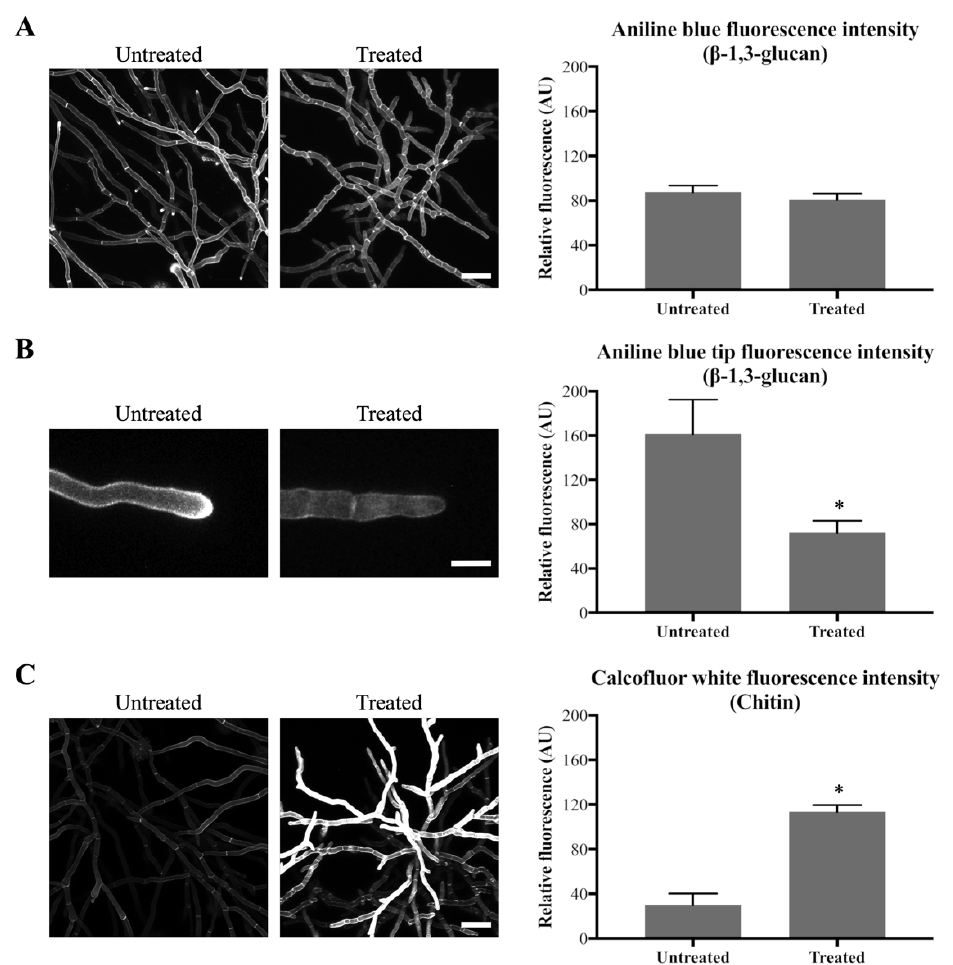
Figure 3. Olorofim causes cell wall remodeling as indicated by Aniline Blue ( β -1,3-glucan) and CFW (chitin) staining. Fluorescence images and measurements are shown on the left and right panels, respectively; error bars represent the SD: ( A ) Aniline Blue ( β -1,3-glucan) staining. No di ff erence in overall fluorescence intensity of mycelial hyphae before and after treatment with 0.1 µ g / mL olorofim for 24 h. Scale bar = 40 µ m; ( B ) Aniline Blue ( β -1,3-glucan) staining. Reduction in β -1,3-glucan in hyphal tips at the colony periphery following treatment. Scale bar = 10 µ m; ( C ) CFW (chitin) staining. Chitin content was increased in the treated hyphae throughout the mycelium. Scale bar = 40 µ m. * p < 0.01.